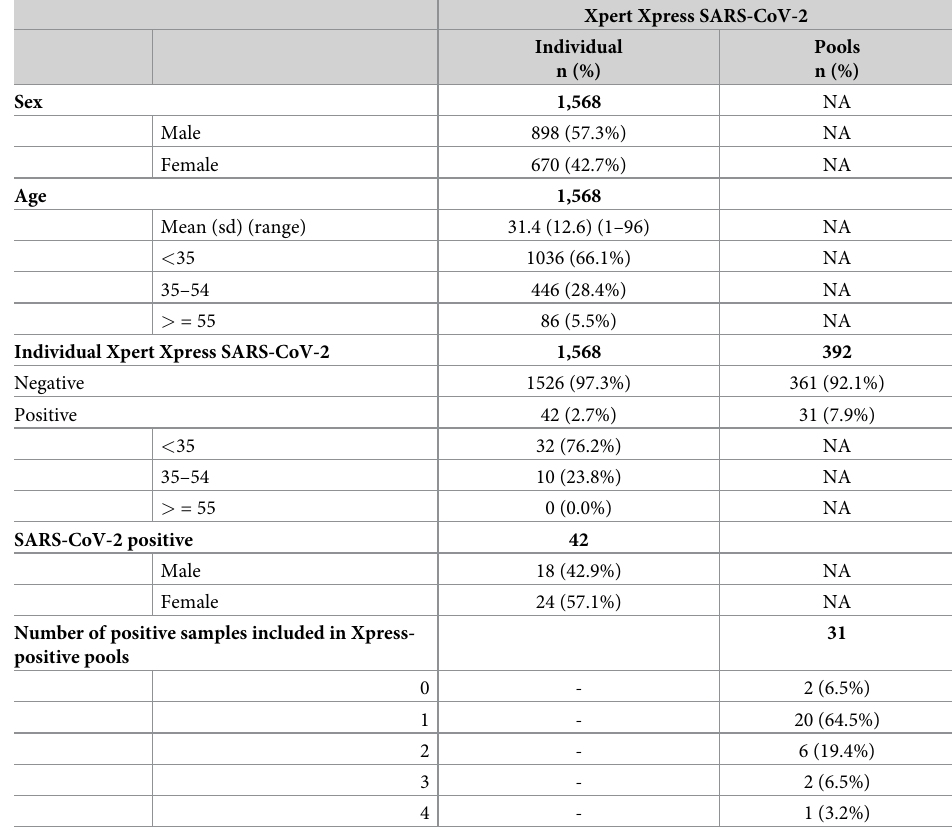
Table 1. Baseline characteristics of participants with single and pooled Xpert Xpress SARS-CoV-2